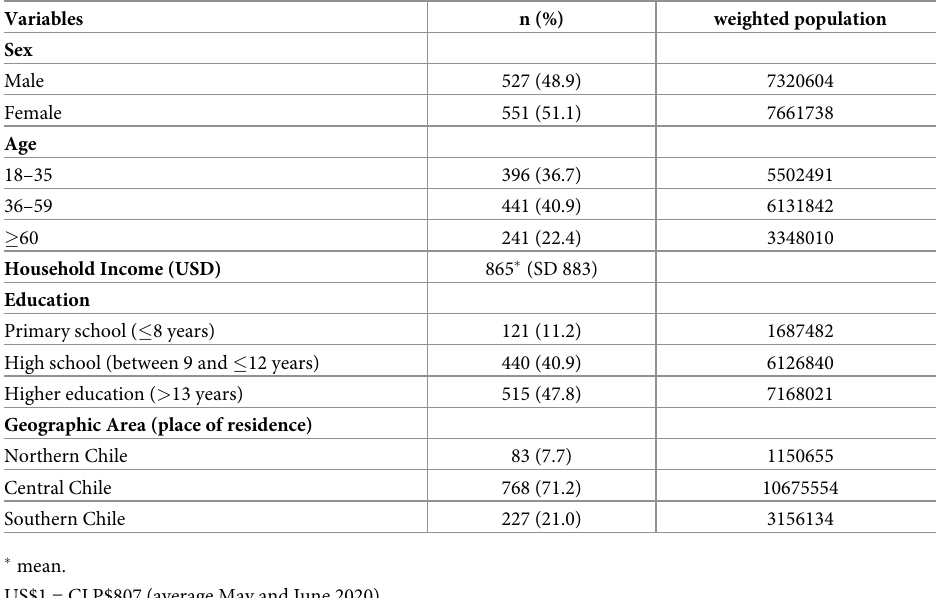
Table 1. Sociodemographic characteristics of the